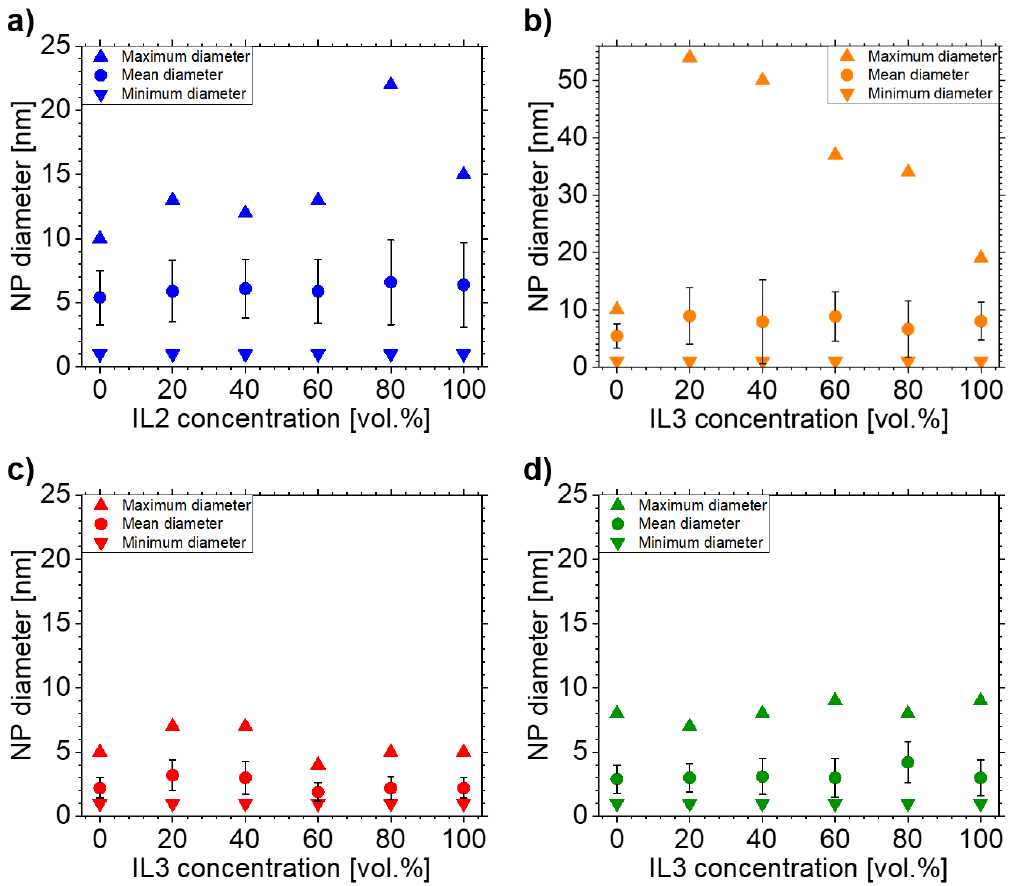
Figure 7. Overview of the different size parameters of all NP/IL-mixture combinations. Minimum and maximum NP diameter as well as the mean diameter of the NPs with error are depicted in ( a ) for Ag in IL1/IL2 -mixtures, in ( b ) for Ag in IL1/IL3 -mixtures, in ( c ) for Au in IL1/IL3 -mixtures and in ( d ) for Cu in IL1/IL3 -mixtures.